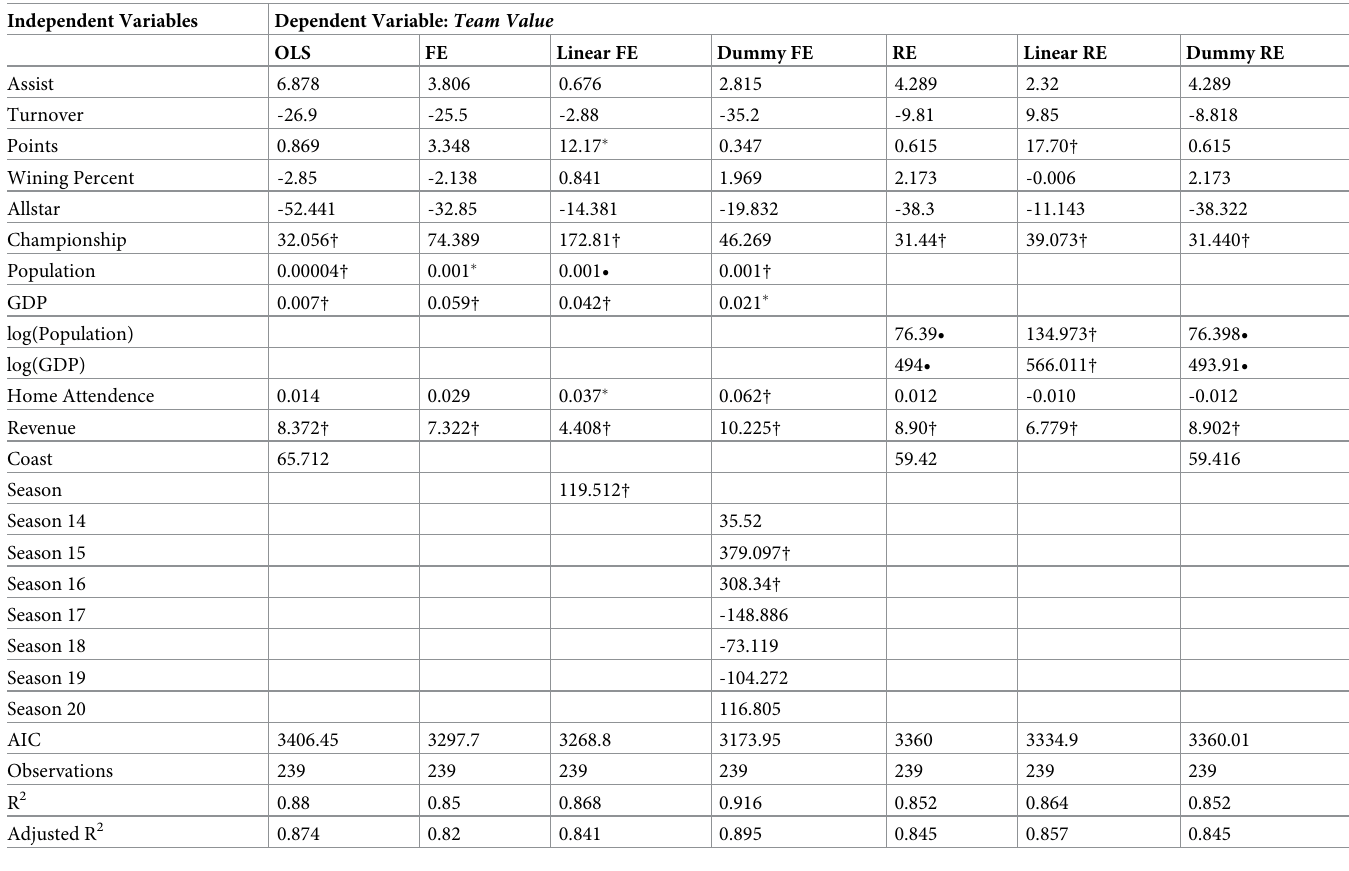
Table 4. Comparison of dynamic linear models.